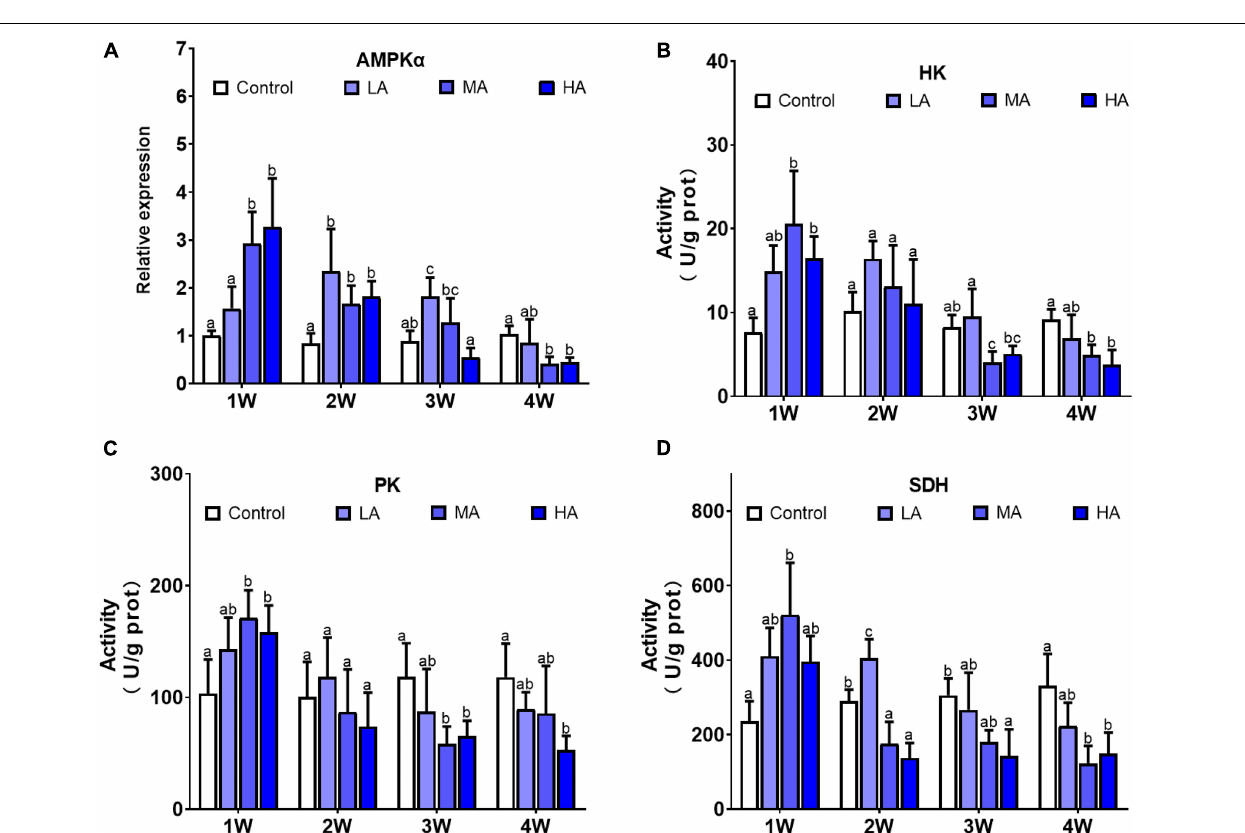
Values are means ± SD (n = 3). Values with different letters in the same column at each time point are significantly different (P < 0.05).